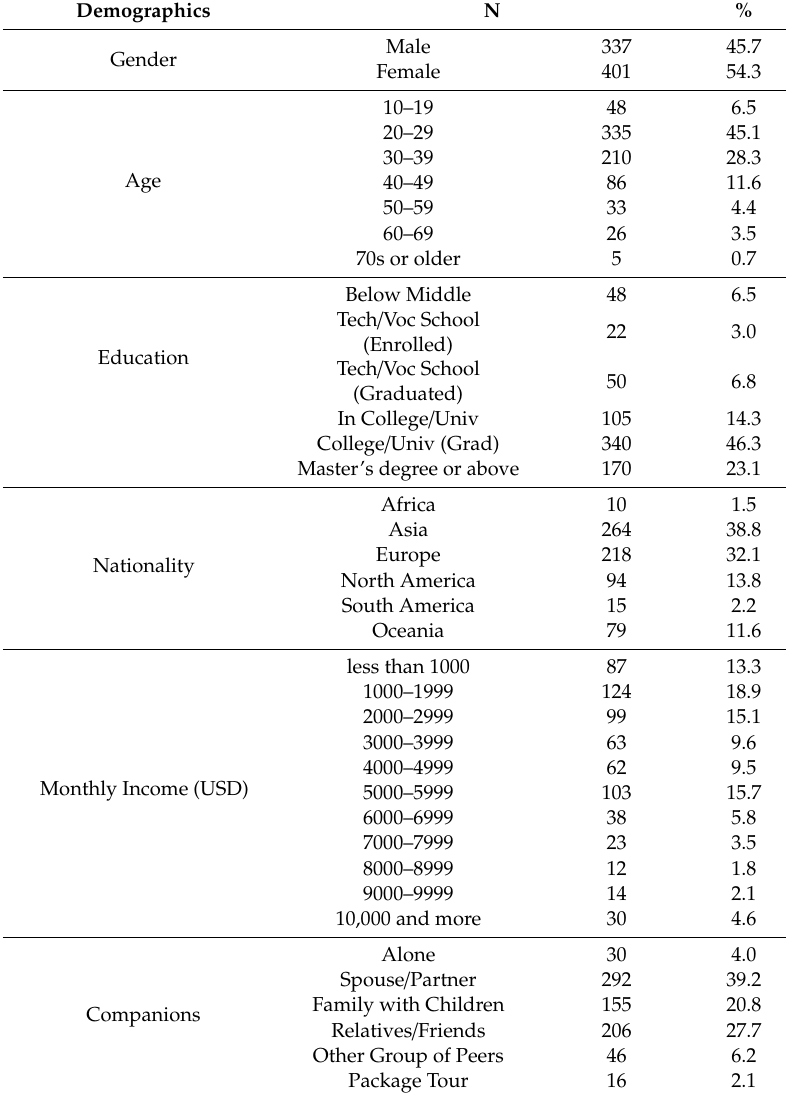
Table 1. Demographic background of